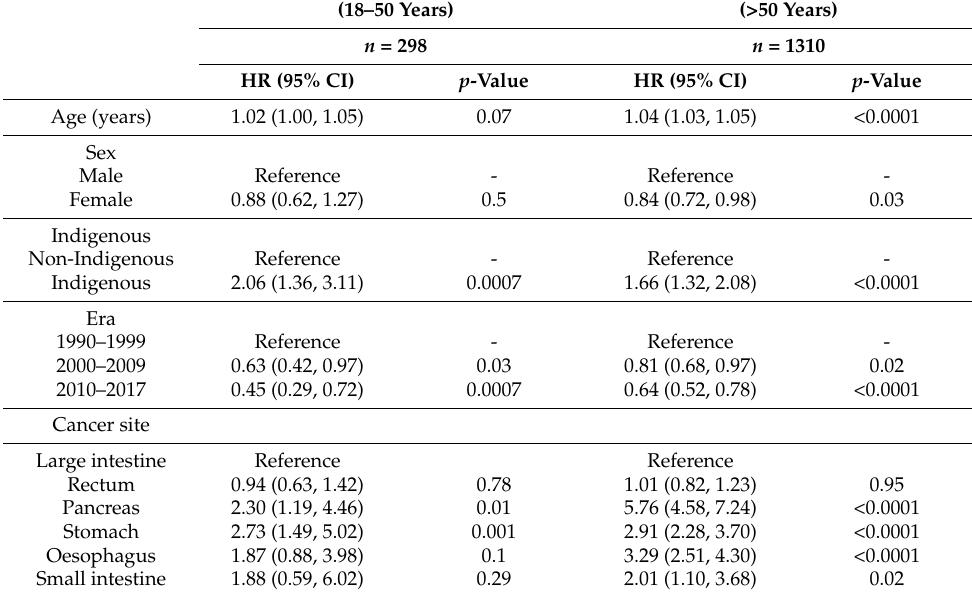
Table 4. Hazard ratios (HR) and 95% CI (Cox proportional hazard model) for age, sex, era, and cancer sites between two age groups ( n =